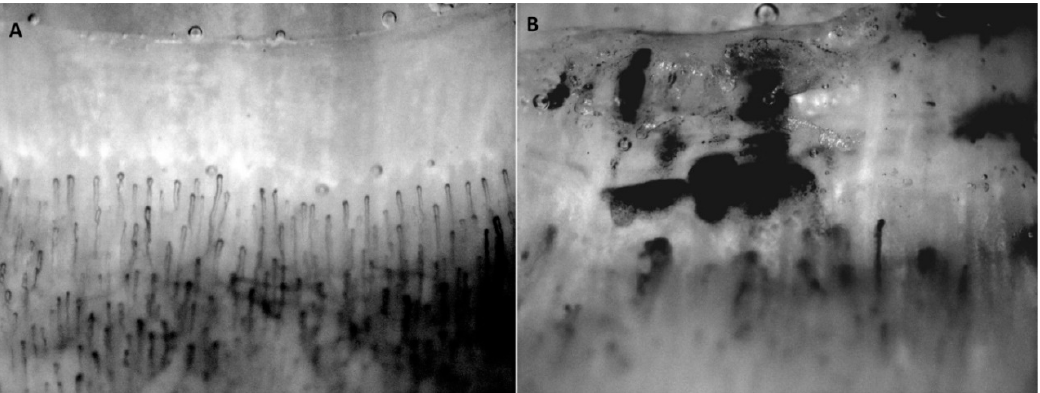
Figure 3. Nail-fold capillaroscopy patterns of a healthy subject ( A ) and a subject with systemic sclerosis (SSc) ( B ). The images of the nailfolds were taken at 180×